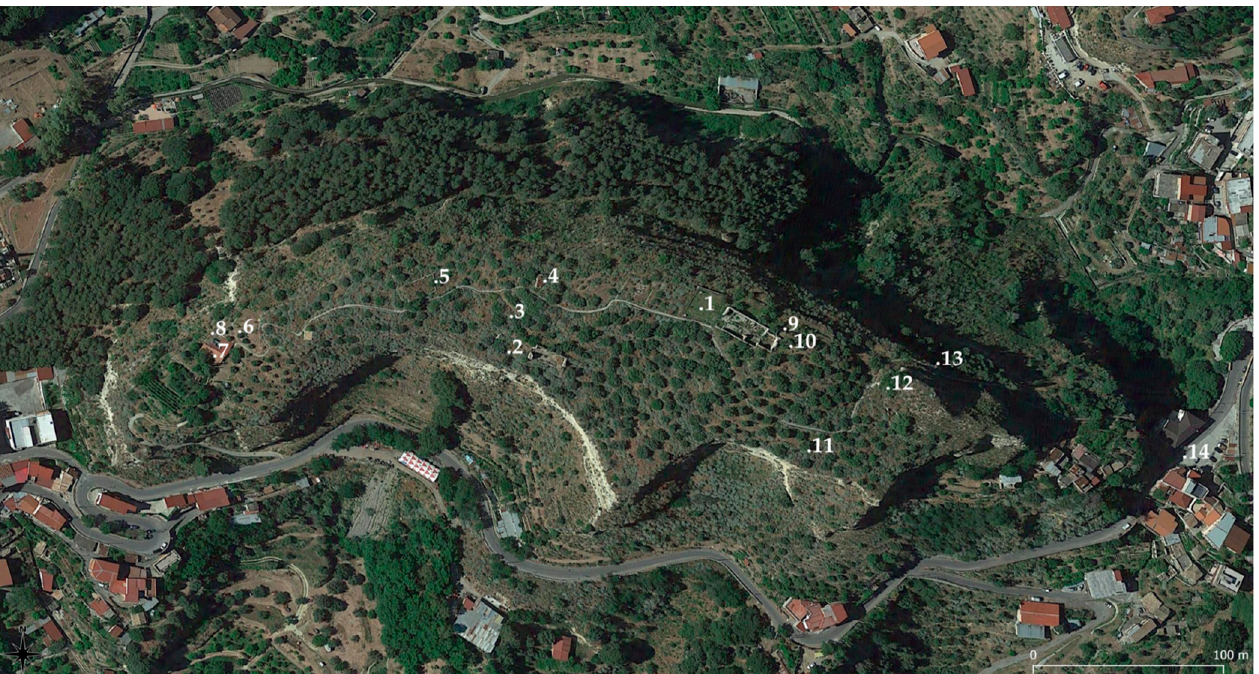
Figure 3. Mapping of the structures cited in this work on satellite map: 1. Church of San Nicola; 2. Church of San Basilio; 3. Borruto Palace; 4. Mazzone Palace; 5. Governor’s Palace; 6. Traces of fortifications; 7. Church del Soccorso; 8. Suburb of San Teodoro; 9. Bell Tower; 10. Church della Provvidenza; 11. Columbo Palace; 12. Castle; 13. Porta di Terra; 14. Piazza Arghelle, Cataforio (start point of the pedestrian path).